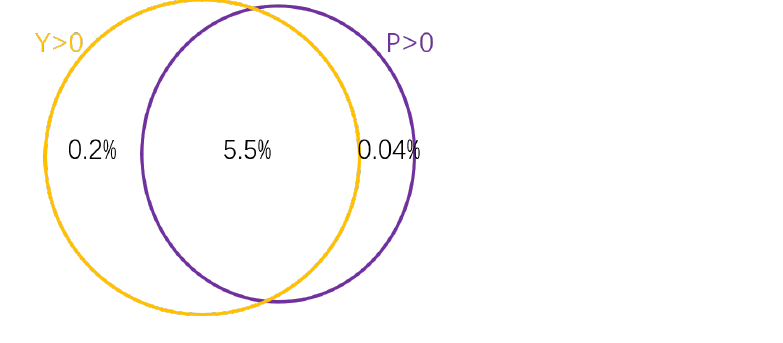
Figure 7 . Comparison of the Y bounds and the linear P > 0 bounds. These two sets of bounds are very